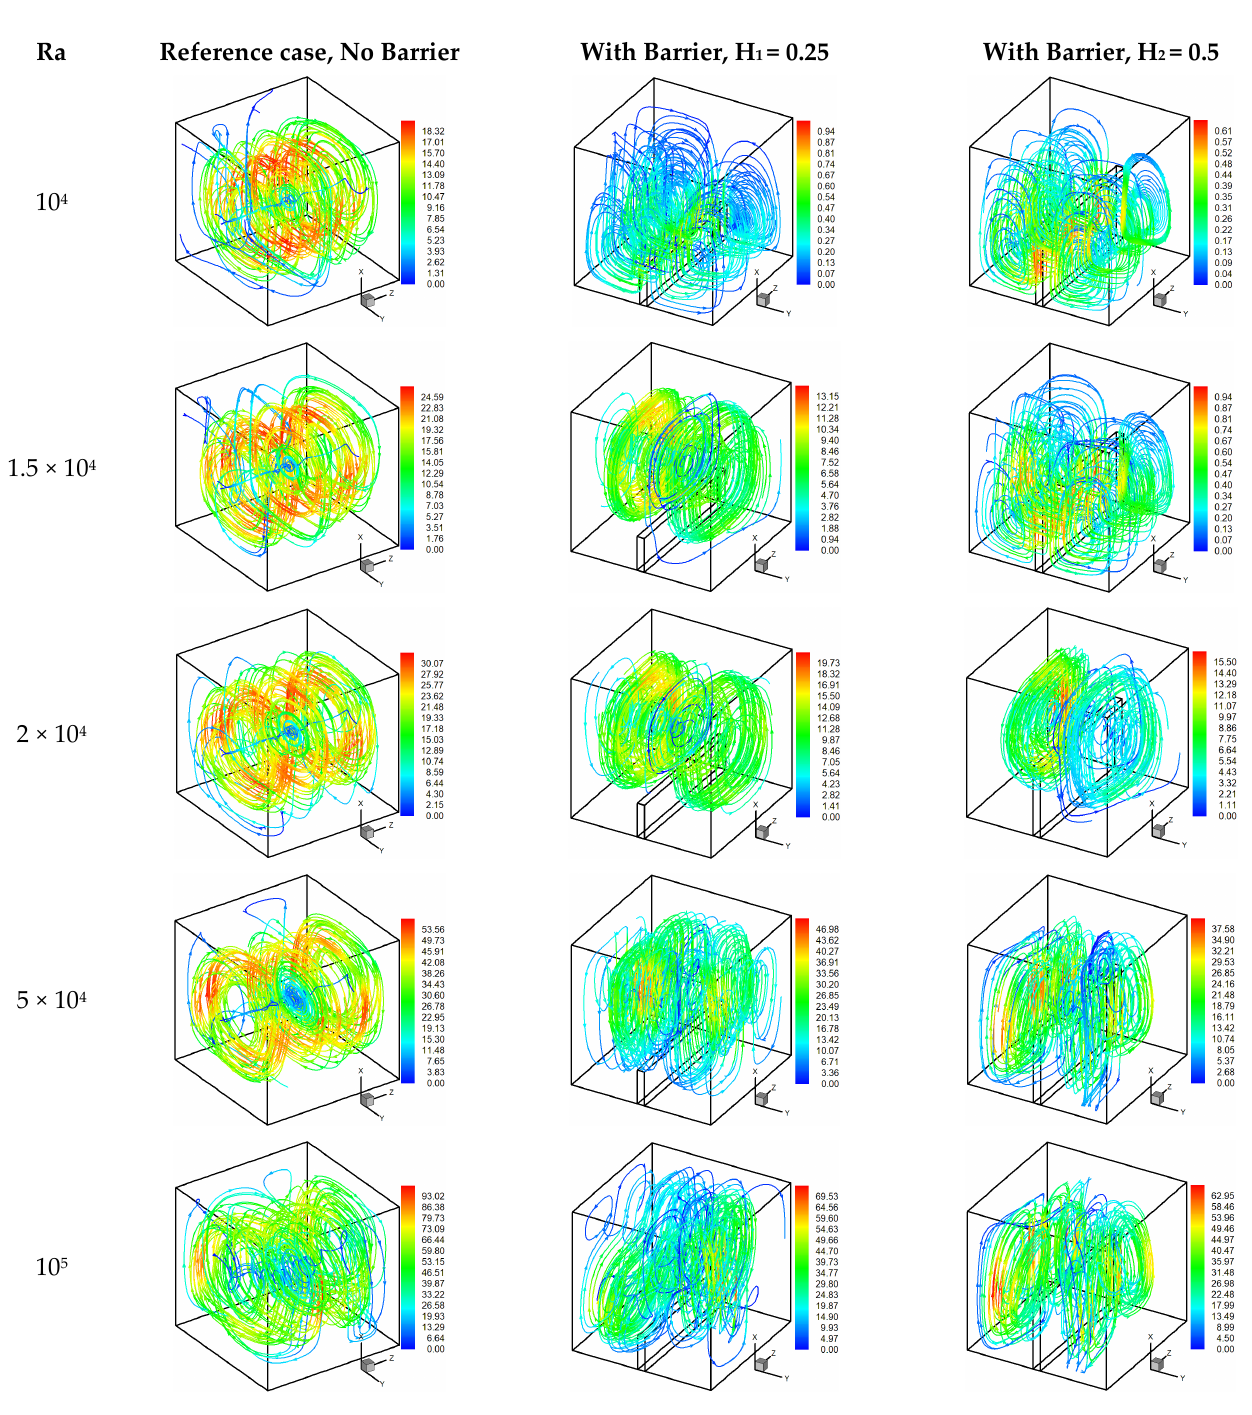
Figure 8. Particles’ trajectories of the fluid in the building for different Ra, effect of two barriers’ heights for N = −0.2.